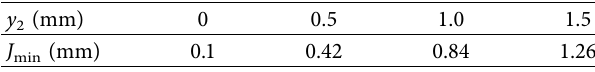
min and y 2 . 2 and J min .